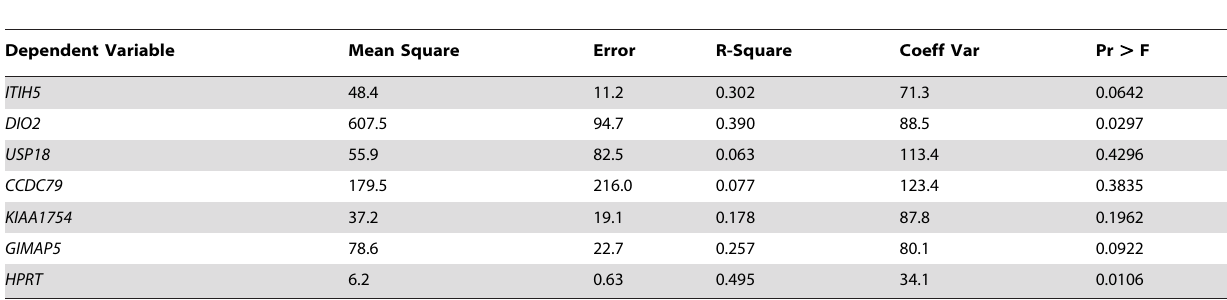
Table 5. ANOVA results of the genes studied in the liver by Real-time PCR assay from animals supplemented with 5 g of inulin kg 2 1 diet and